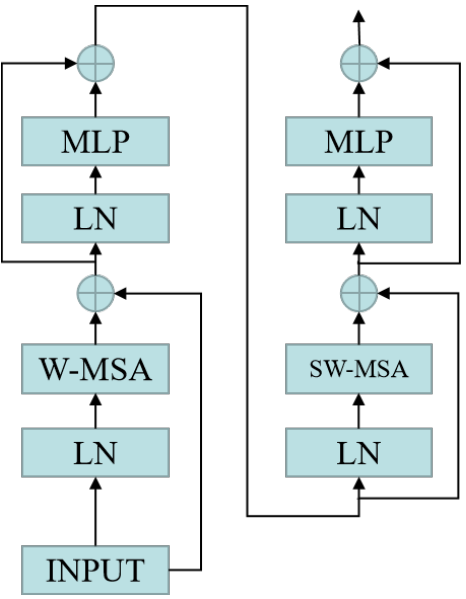
Figure 4. The architecture diagram of swin